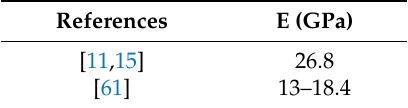
Table 7. Young’s modulus of C-S-H obtained from previous